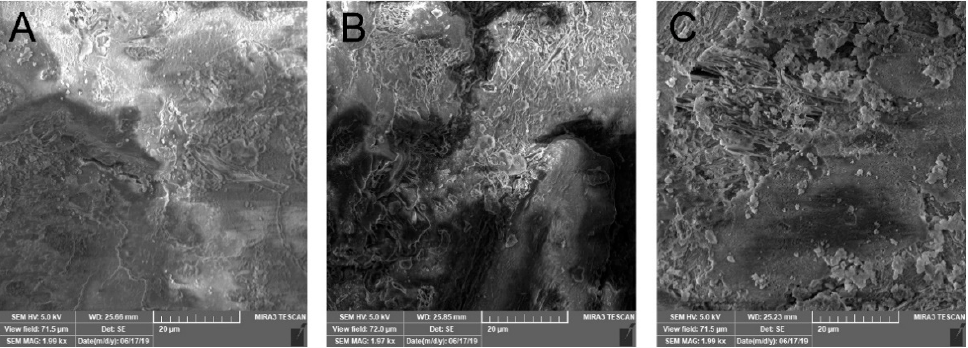
Figure 4. SEM surface topography of the selected samples of matrix tablets: ( A ) N75M50, ( B ) M125, ( C ) N125.